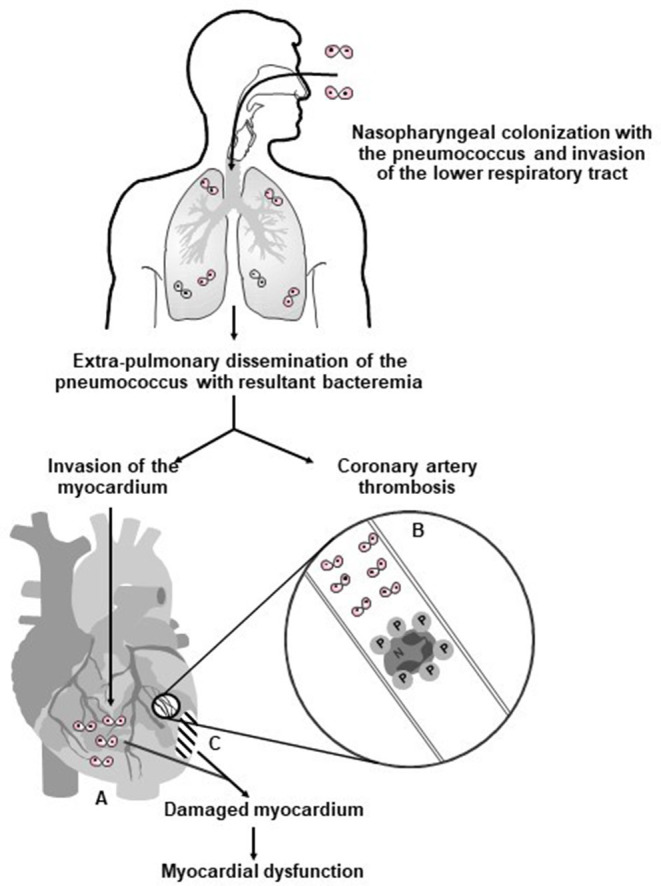
Proposed mechanisms involved in the pathogenesis of pneumolysin-mediated myocardial injury during invasive pneumococcal disease in humans. Following nasopharyngeal colonization, invasion of the lower respiratory tract, extra-pulmonary dissemination, and cardiac invasion by the pneumococcus (⊙⊙–symbol represents diplococci), intra-myocardial and intravascular release of pneumolysin (PLY) by the pathogen results in (A) PLY-mediated death and dysfunction of cardiomyocytes; (B) intravascular activation of platelets and neutrophils with resultant formation of pro-thrombotic/pro-NETotic neutrophil (N):platelet (P) aggregates (as illustrated in the magnification of an affected coronary arteriole/artery); and (C) development of myocardial damage and dysfunction. Reproduced with permission of Anderson et al. (28) under a Creative Commons License (https://creativecommons.org/licenses/by/4.0/).